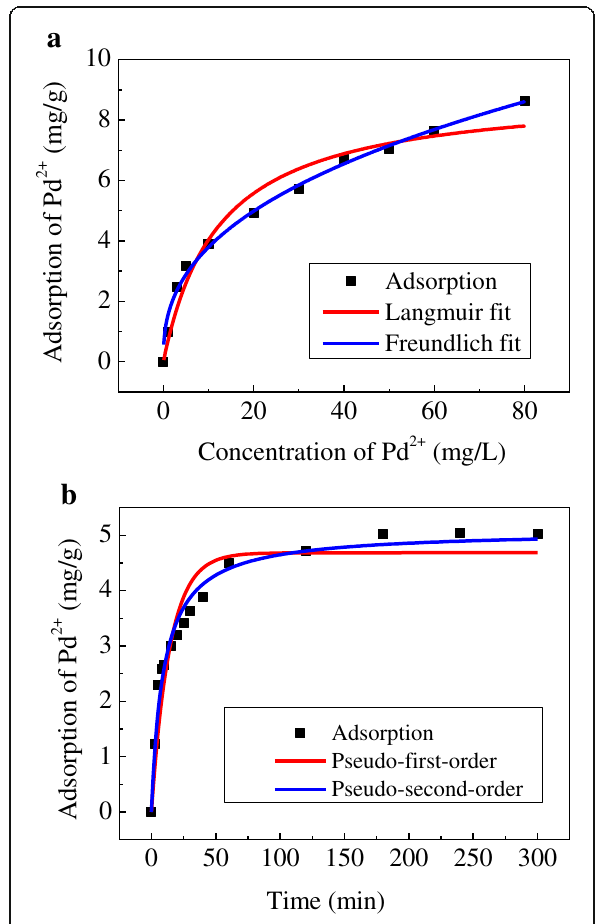
Fig. 6 a Adsorption isothermal and ( b ) kinetic fitting curves of Pd(II) on Pd(II) IIPs